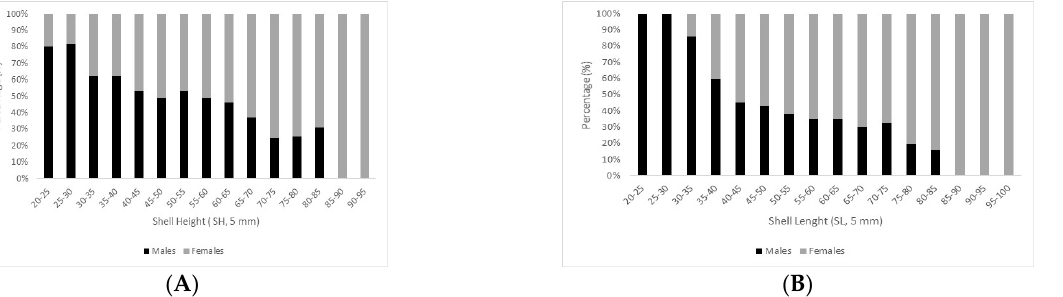
Figure 3. Size frequency distribution of males and females of the species Pinctada capensis ( A ) and Saccostrea cucullata ( B ) from Inhaca Island.